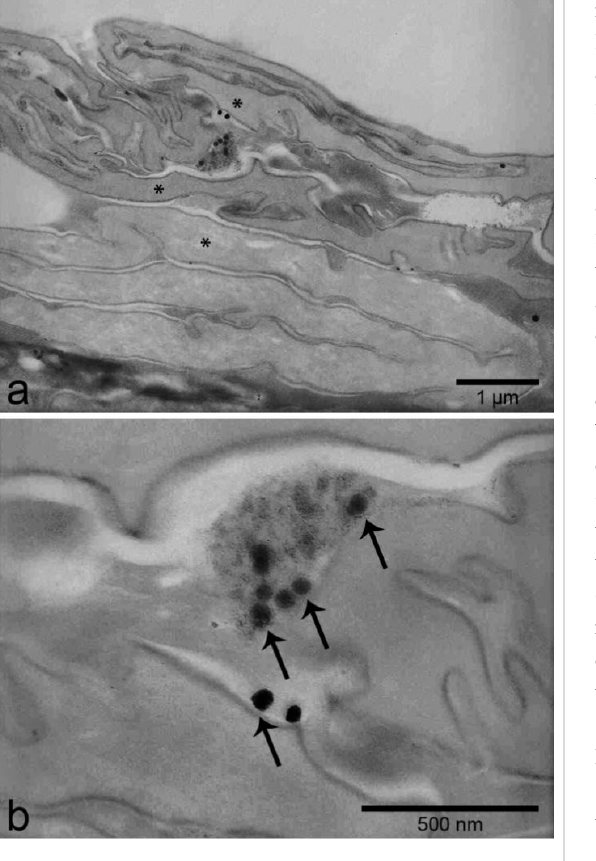
Figure 8: Transmission electron microscopic detection of single elec- tron-dense SiO 2 -NP (55 ± 6 nm in diameter) between corneocytes (asterisks) of the mouse skin (a). Higher magnification of the same region (b) reveals single spherical nanoparticles (arrows). Sections were prepared without uranyl acetate and lead citrate